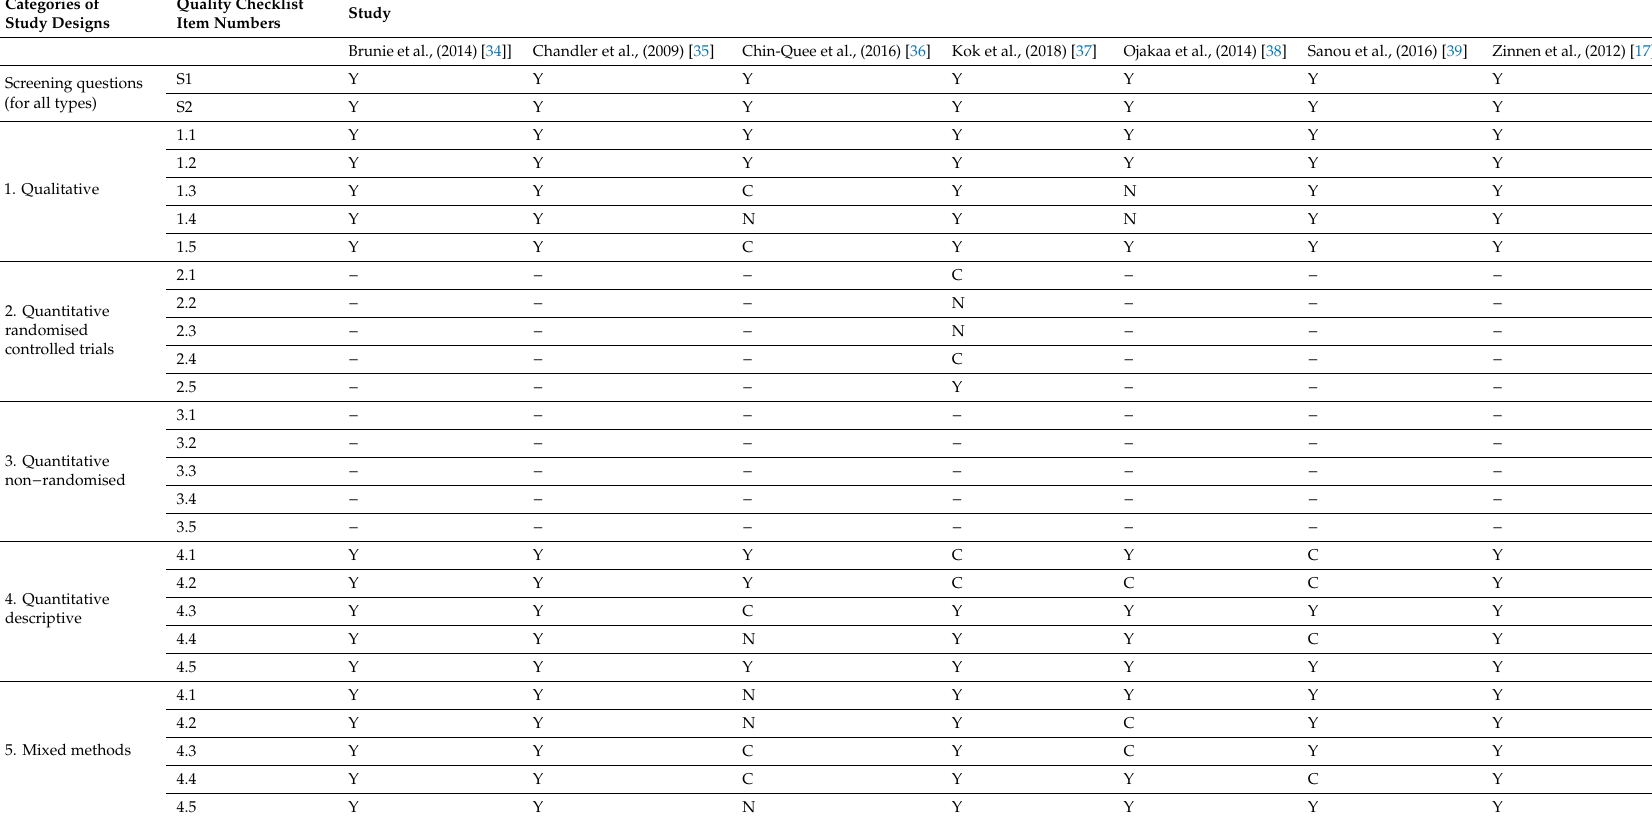
Table 6. Methodological quality of mixed methods studies